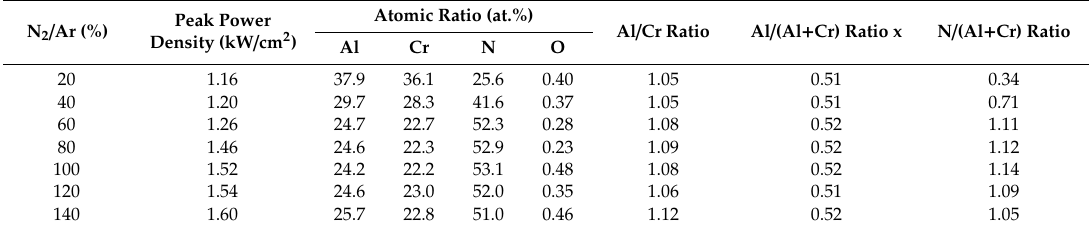
Table 1. N 2 / Ar flow ratios and corresponding e ff ects on peak power density and concentrations of constituent elements in CrAlN